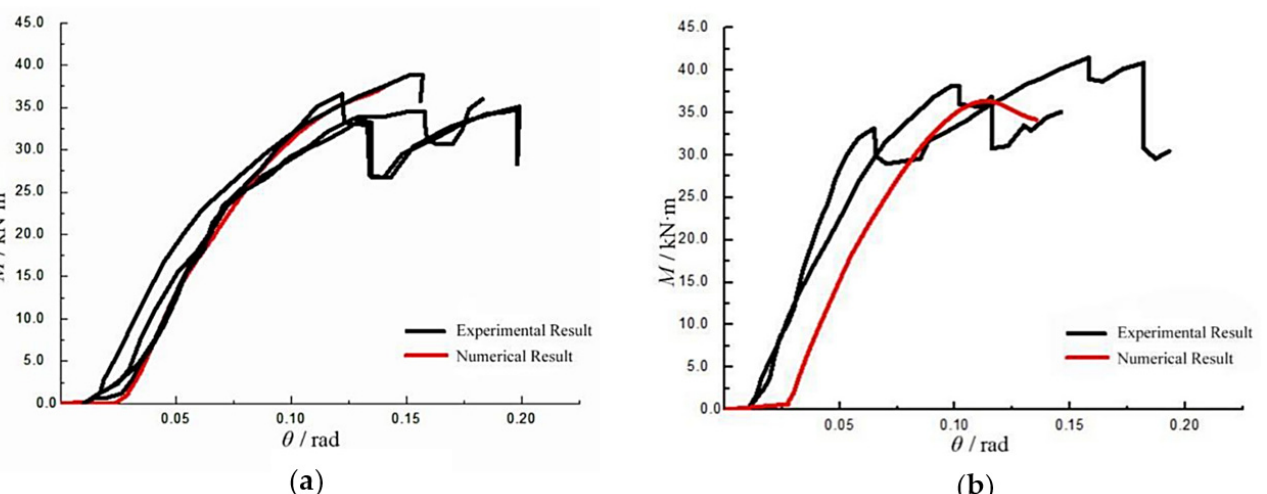
Figure 11. Comparison of the failure modes [33]: ( a ) finite element model, ( b ) specimen from [20], ( c ) specimen from [31], and ( d ) specimen, adapted from [25].